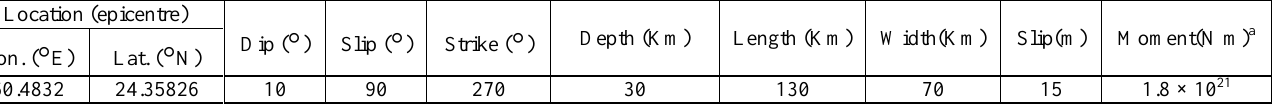
Table 1. Seismic parameters of the Makran tsunami of worst case